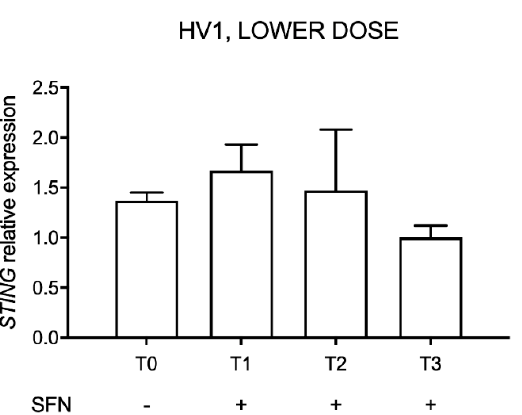
Figure 6. STING expression after sulforaphane (SFN) supplement consumption in the first volunteer (HV1). Data are reported evaluating 2 −ΔΔ Ct values considering the last day of assumption as calibrator (T3), using HPRT1 and G6DP housekeeping genes as reference.